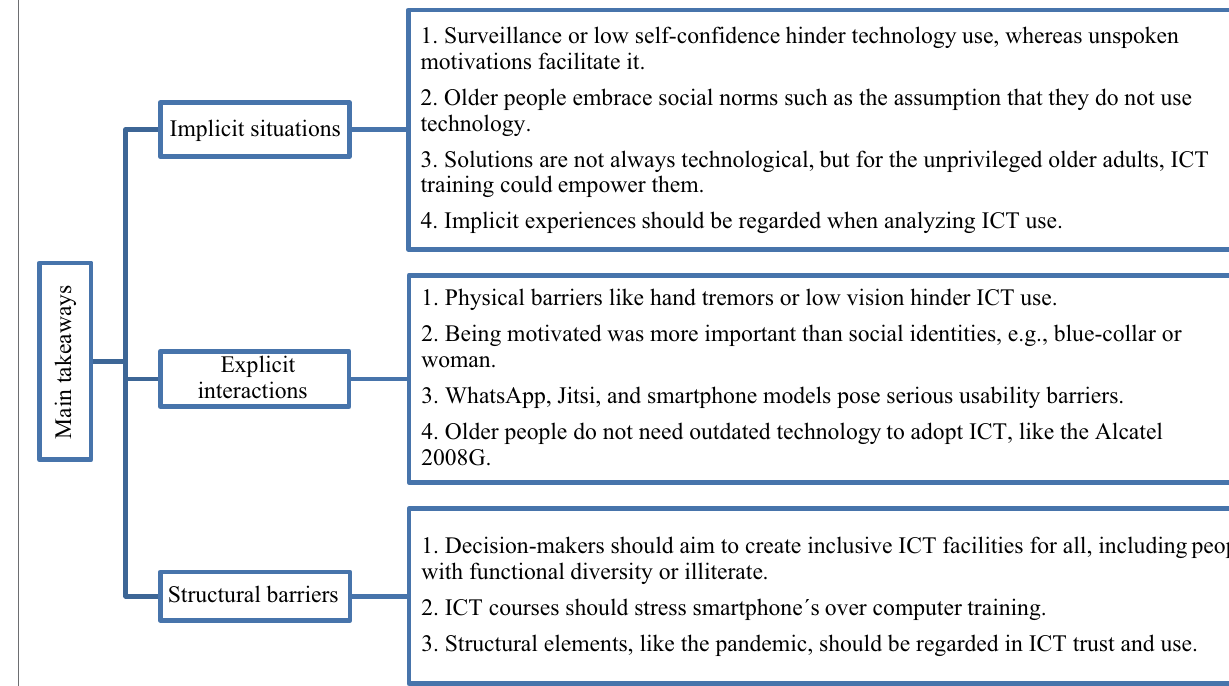
FIGURE 2 | Main implications of the